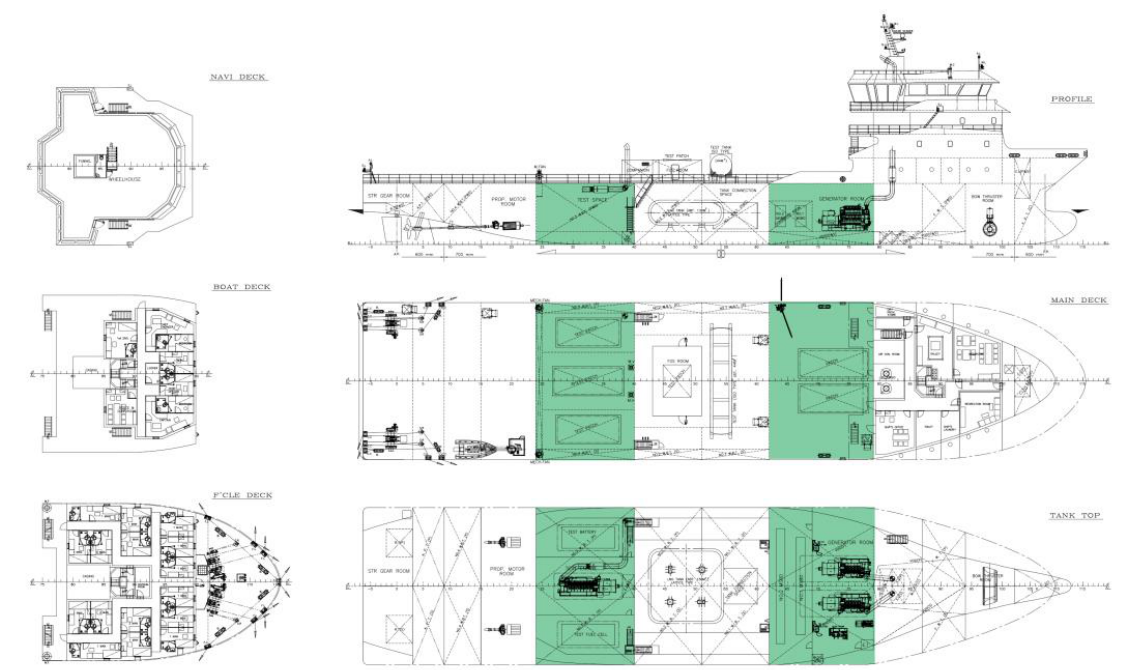
Figure 16. Conceptual design and location of BSS installation, as verified by the general arrangement of K-GTB.